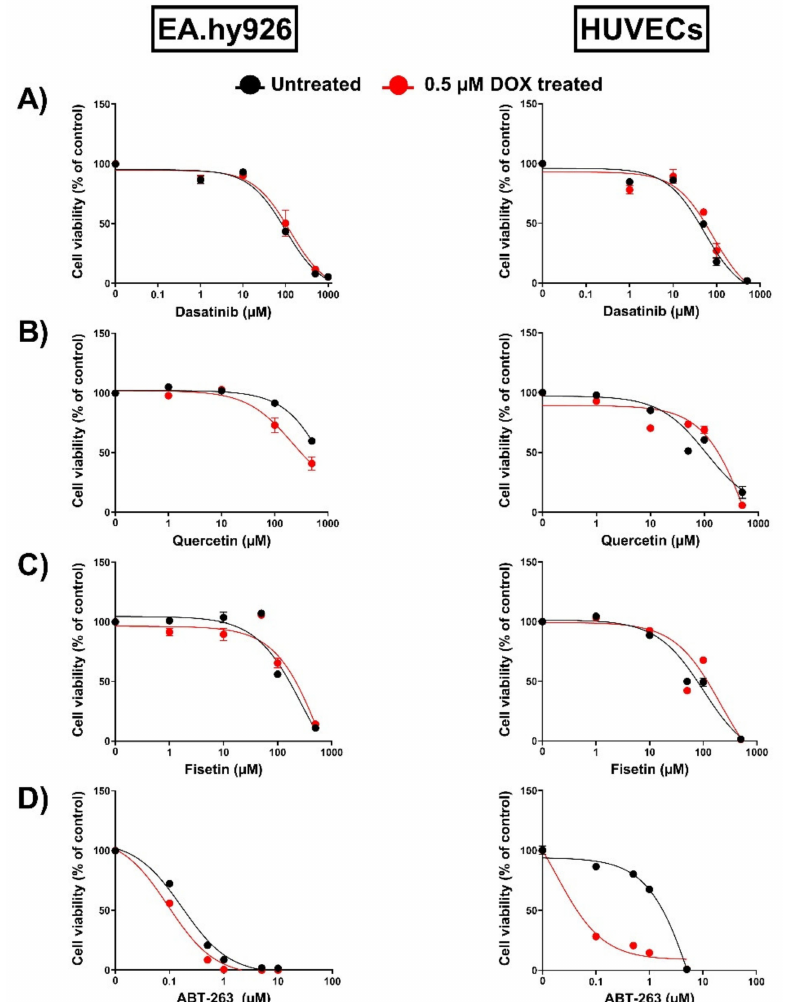
Figure 5. Assessment of the activity of multiple senolytics in EA.hy926 cells and HUVECs. Both EA.hy926 human-endothelial-derived cells and HUVECs were treated with DOX (0.5 µ M) for 24 h to establish the senescence phenotype or left untreated. Three days post DOX exposure, DOX-treated and untreated cells were incubated with increasing concentrations of different senolytics including ( A ) dasatinib, ( B ) quercetin, ( C ) fisetin, and ( D ) ABT-263 for 24 h. Thereafter, the cell viability was measured using MTT assays in both cell lines. The cell viability was calculated relative to control wells and expressed as a percentage. Values are presented as means ±